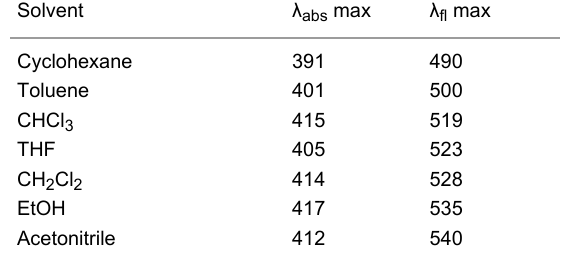
Figure 2: Normalized fluorescence spectra of 4 in ethanol (5 × 10 − 5 M): (solid line) neutral solution; (dashed) acidified solution; (dashed-dot) basic